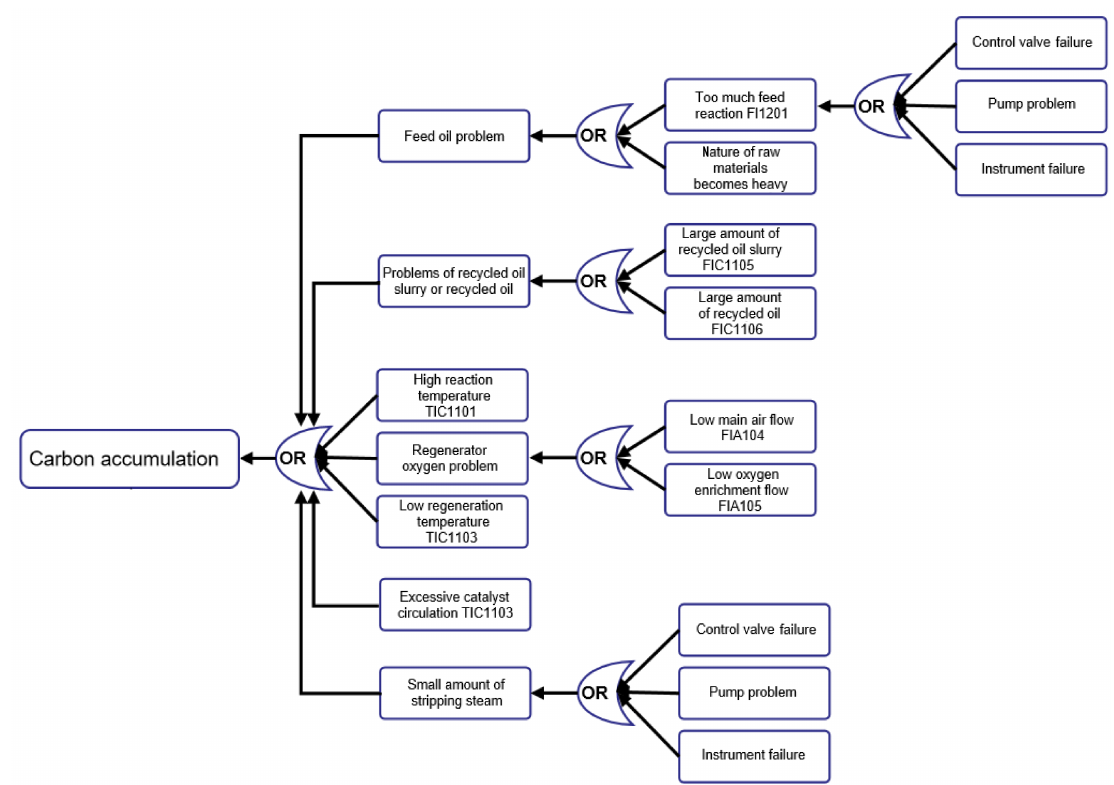
Fig. 4 Fault tree that causes abnormal conditions of FCC carbon accumulation Œ 126 (cid:141)